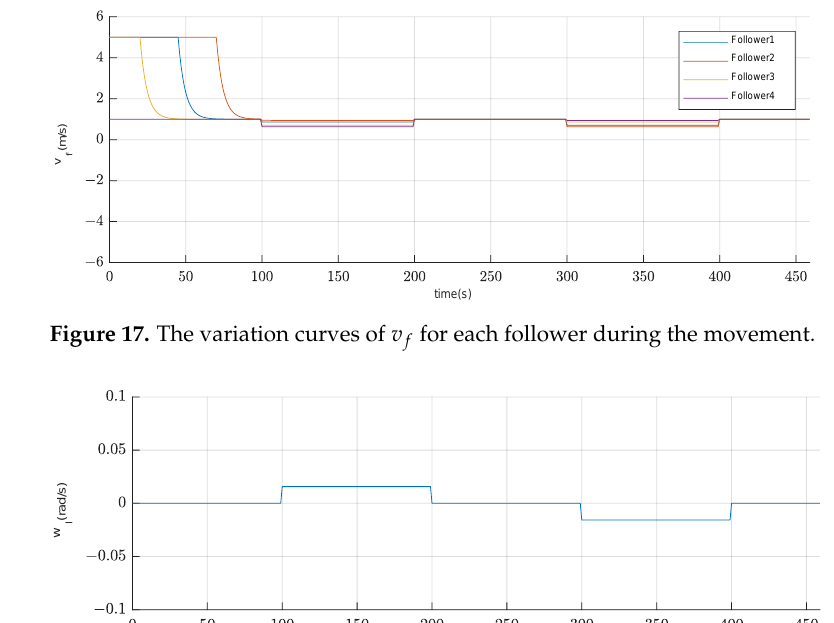
for the leader during the movement. 𝜔𝜔 𝑙𝑙